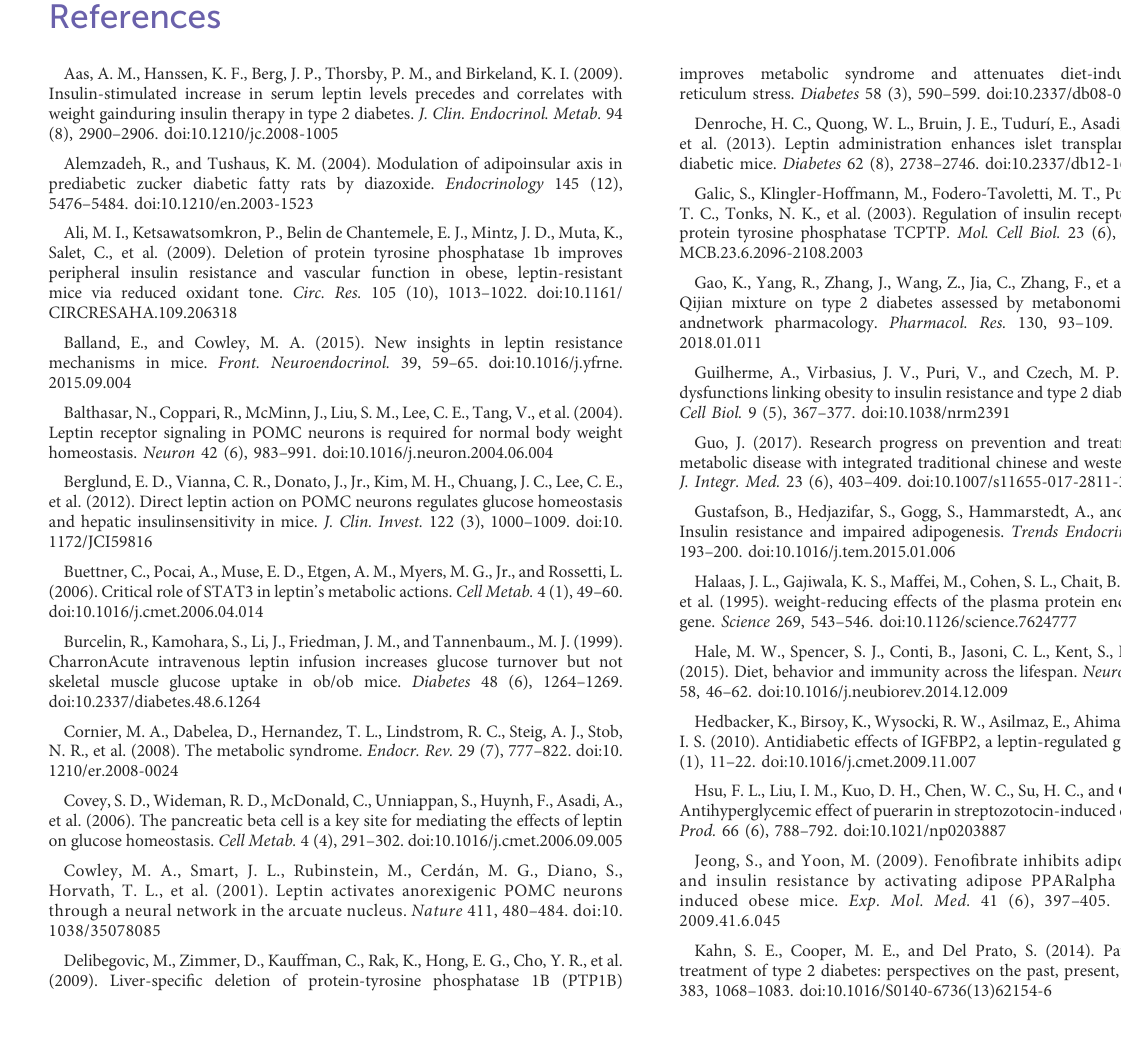
Representative hematoxylin and eosin staining of livers from each group after treatment with APF 12 weeks. SUPPLEMENTARY FIGURE S3 Representative hematoxylin and eosin staining of epididymal fat from each group after treatment with APF 12 weeks. SUPPLEMENTARY FIGURE S4